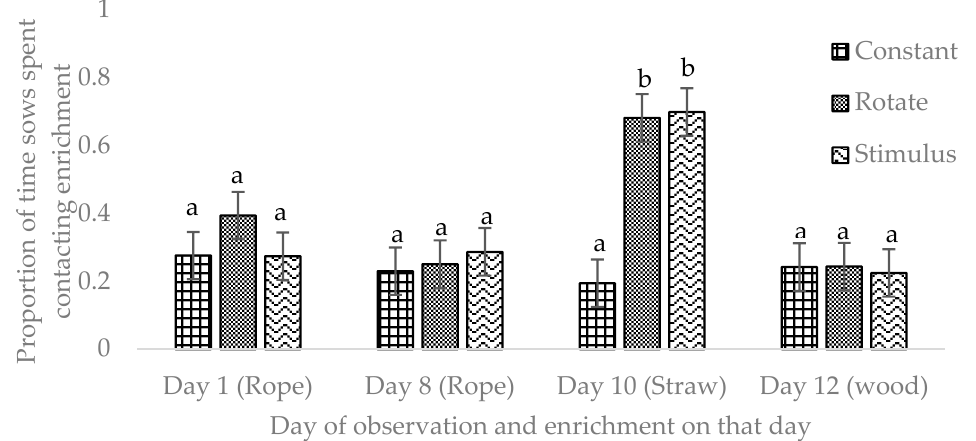
Figure 4. Proportion of time sows contacted enrichments (rope, wood or straw) and day of observation (days 1, 8, 10 and 12) in the Constant, Rotate and Stimulus treatments. Proportion of time was calculated as the proportions of scans (time lapse photos at 10-min intervals) where the behavior was observed out of the total number of scans during an 8-h period (8:00–16:00 h) on four days (1, 8, 10 and 12). Note: sows in the Constant treatment received the wood enrichment on all days ( n = 46, F = 2.95, p < 0.029). a,b Bars without a common superscript are significantly different at p < 0.05.